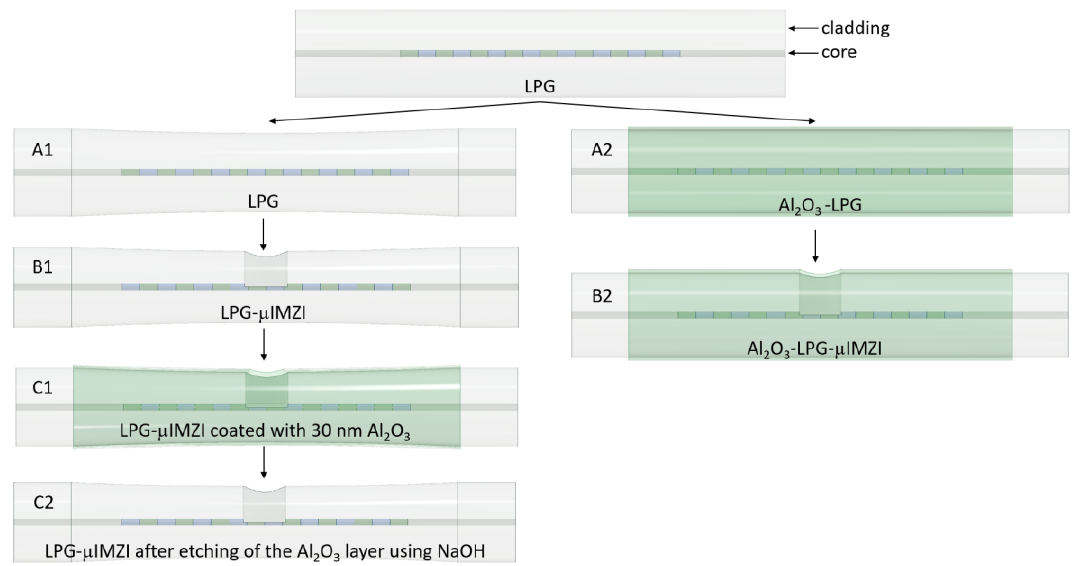
Figure 1. Schematic visualization of the sample preparation, where ( A1 ) represents a long-period grating (LPG) etched with hydrofluoric (HF) acid; ( A2 )—an LPG nanocoated with aluminum oxide (Al 2 O 3 ); ( B1 )—a combination of the microcavity in-line Mach–Zehnder interferometer ( µ IMZI) and etched LPG; ( B2 )—a combination of the µ IMZI and nanocoated LPG; ( C1 )—a LPG- µ IMZI coated with 30 nm Al 2 O 3 layer as a simulation of a biofilm formation; ( C2 )—a LPG- µ IMZI after etching of the Al 2 O 3 layer with sodium hydroxide. Features are not to scale.